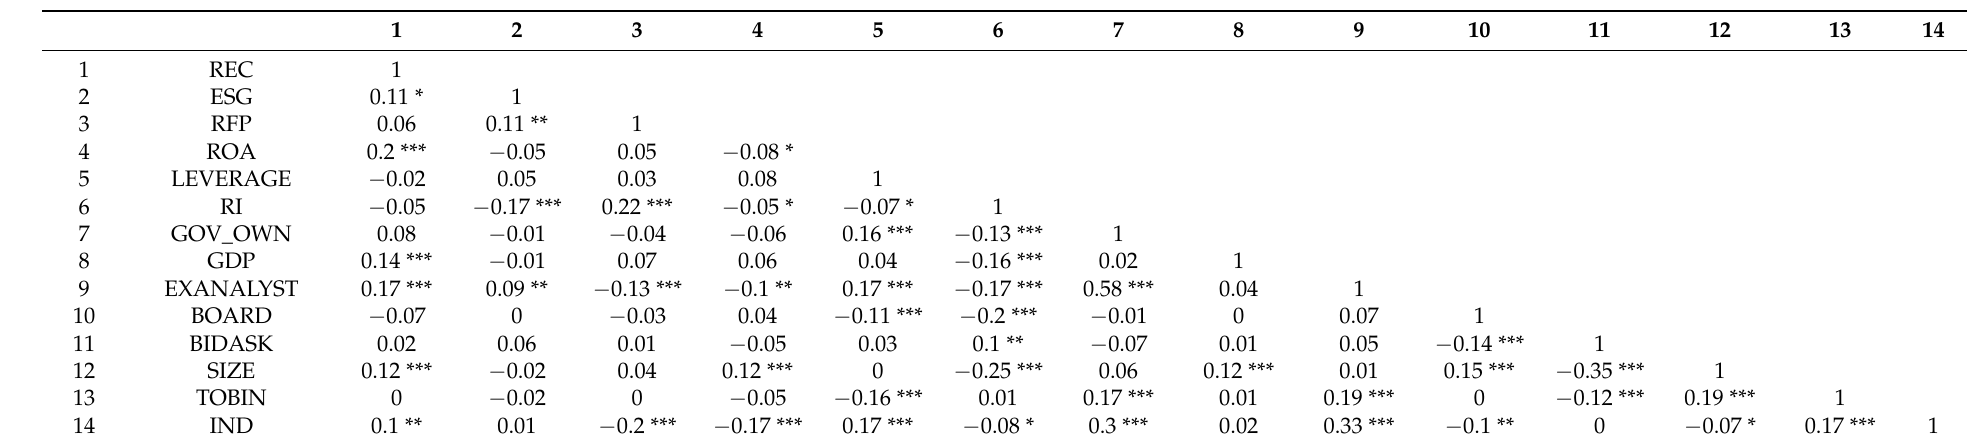
Table 5. Pearson correlation